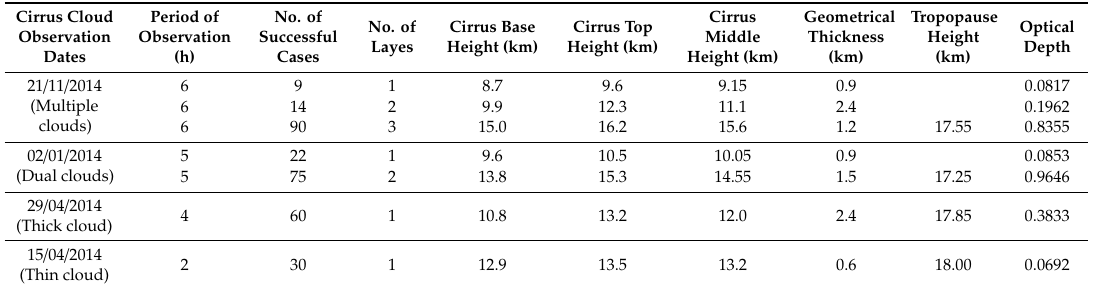
Figure 3. ( a–d ) Typical idealized plots showing several lidar Range Corrected Signal profiles. Table 1. Variance Centroid Method output of geometrical and optical characteristics of cirrus clouds